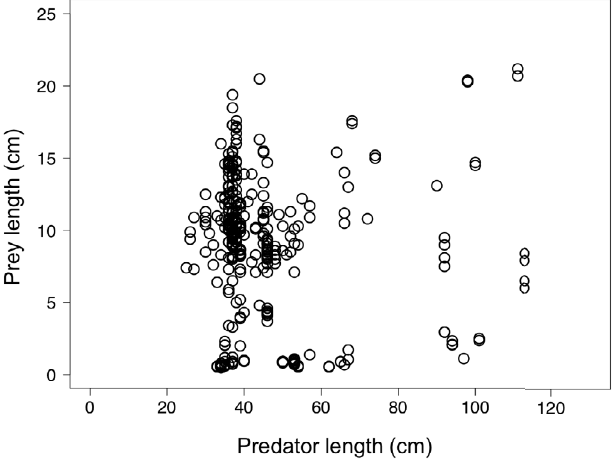
Fig. 3. Relationship between meagre (predator) length and prey fi sh length.